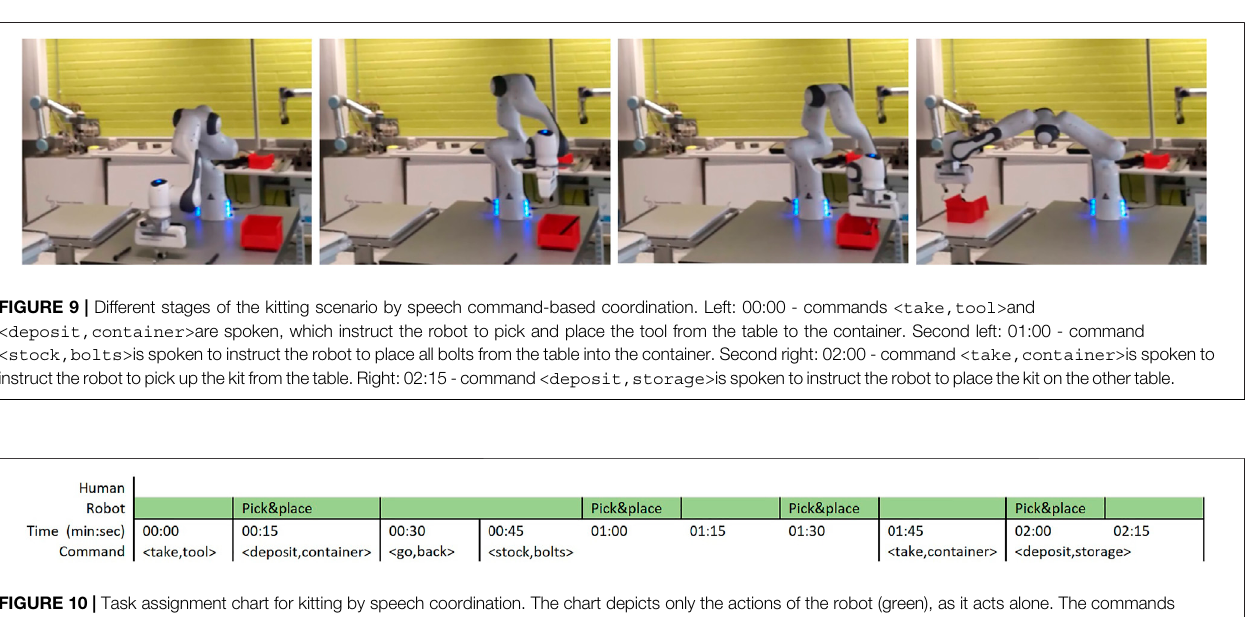
Frontiers in Robotics and AI |